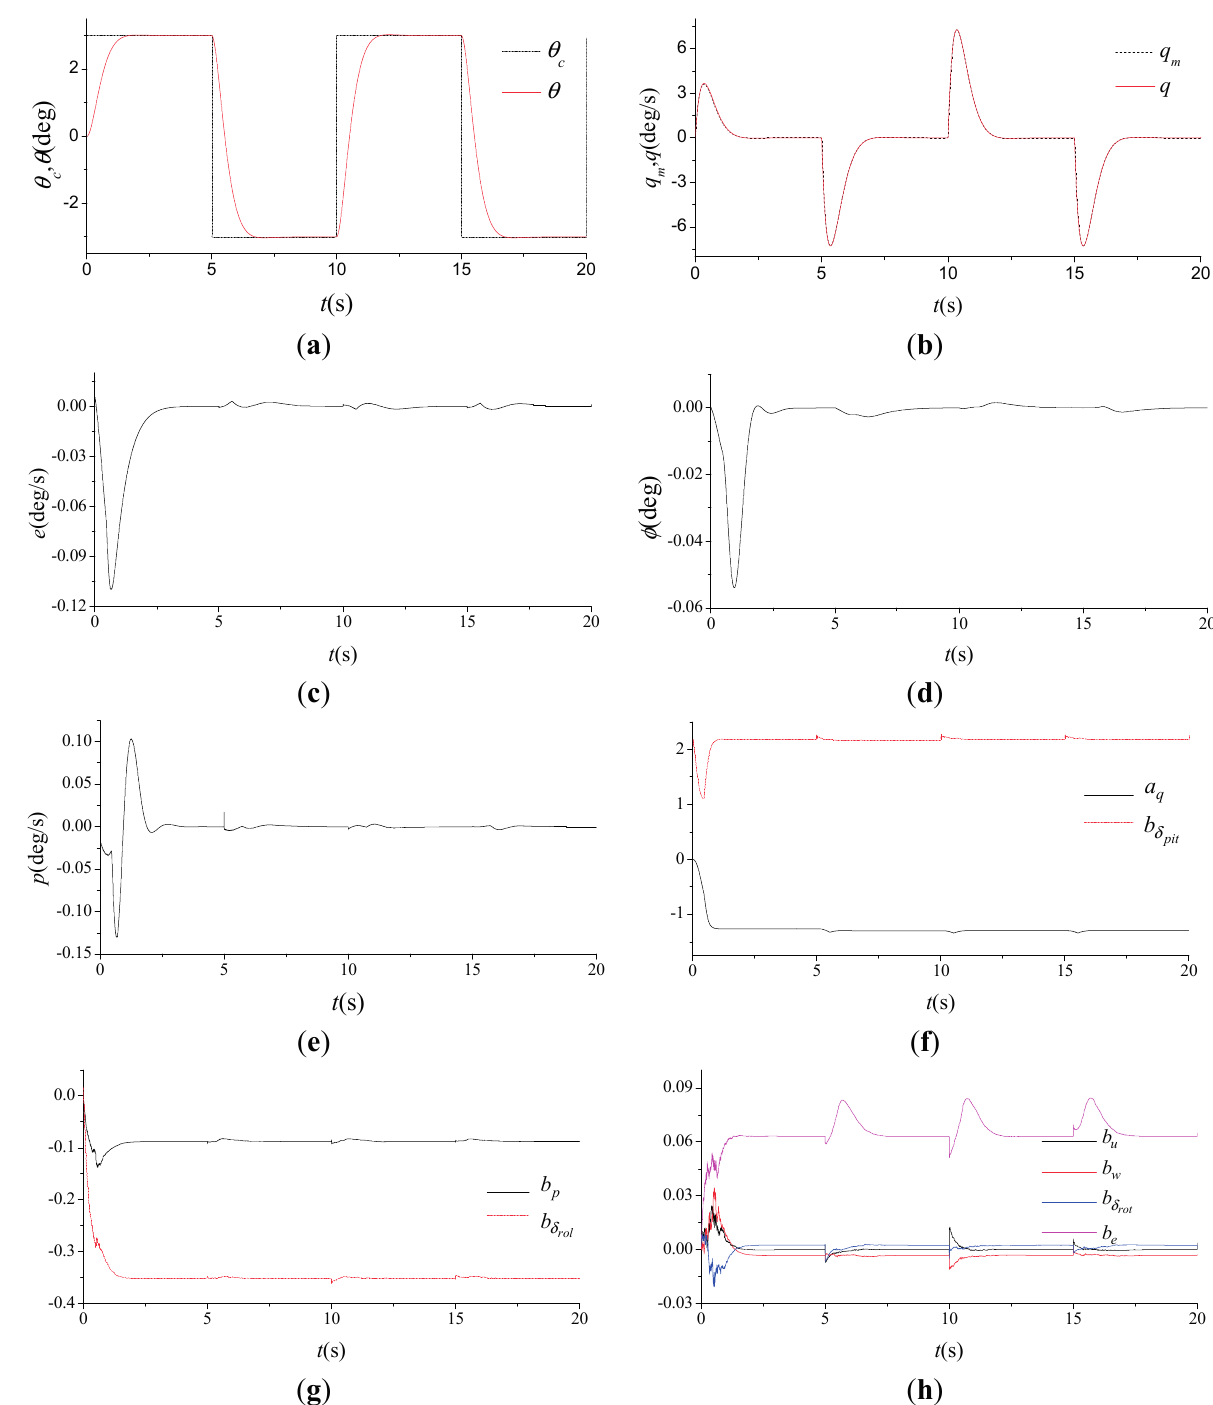
Figure 3. Numerical simulation results of the proposed strategy. ( a ) θ q ; ( c ) e ; ( d ) φ ; ( e ) p ; ( f ), ( g ) and ( h ) Identification